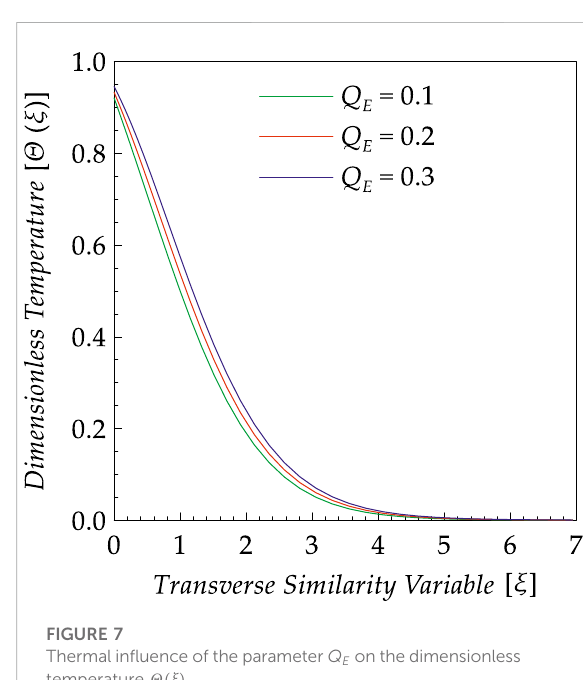
FIGURE 5 Dynamical sway of the parameter M on the dimensionless velocity H ( ξ ) .